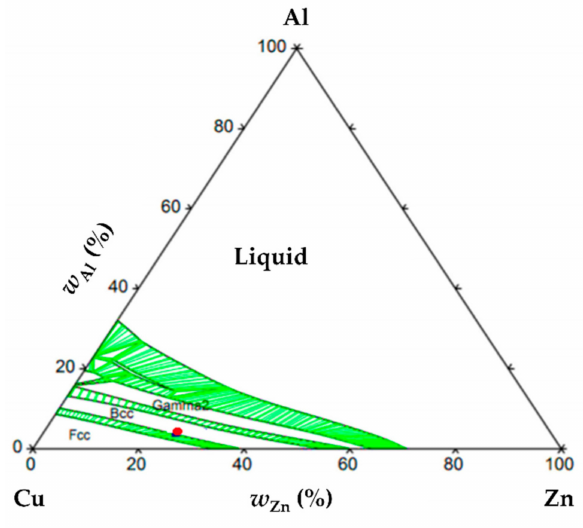
Figure 3. Isothermal section of Al-Cu-Zn calculated for 800 ◦ C